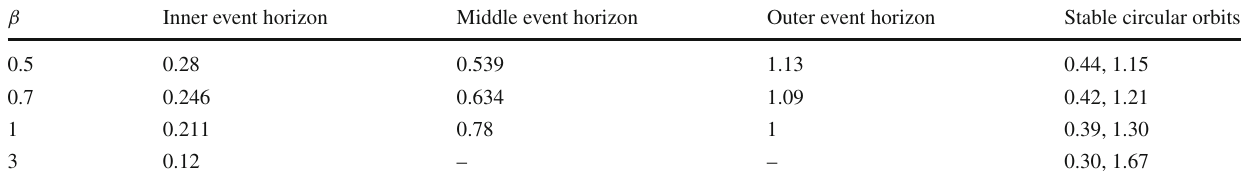
Table 2 Location of the event horizons and the stable circular orbits for the first case ( α = 10) and different values of β around the black hole in